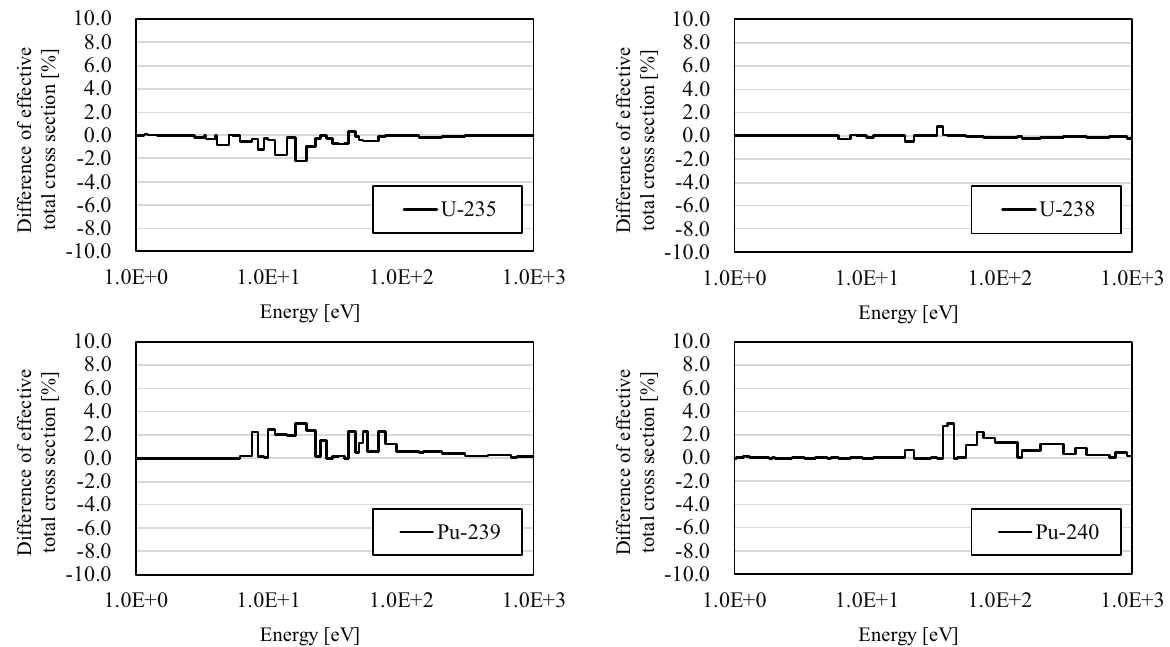
Figure 4. Difference of effective total cross sections in MOX between Fig. 1-(b) and Fig. 1-(c) obtained by UFG with